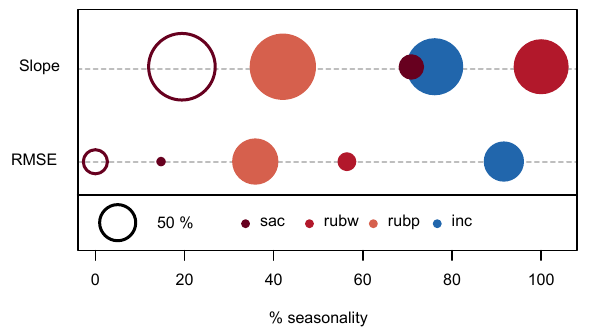
Figure 7. Partitioning of the improvement in the prediction of the fossil δ 18 O signal into seasonality and depth habitat for both RMSE of (cid:49)δ 18 O and the slope between (cid:49)δ 18 O and MAT 0 − 50m . Colours denote species and the size of each dot is proportional to the total improvement achieved. The open circles illustrate the partitioning for T. sacculifer using the palaeotemperature equation of Mulitza et al. (2003).